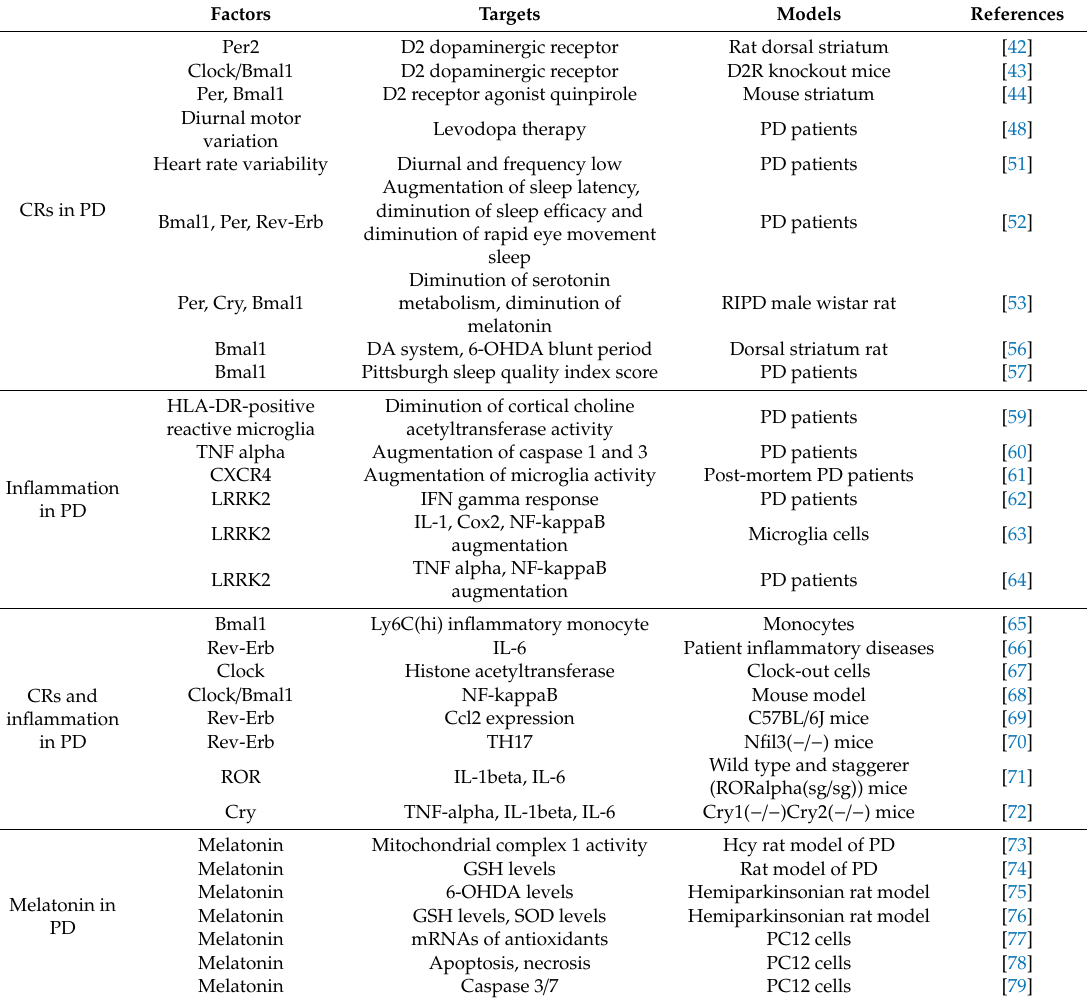
Table 1. CRs, oxidative stress, inflammation and Melatonin in